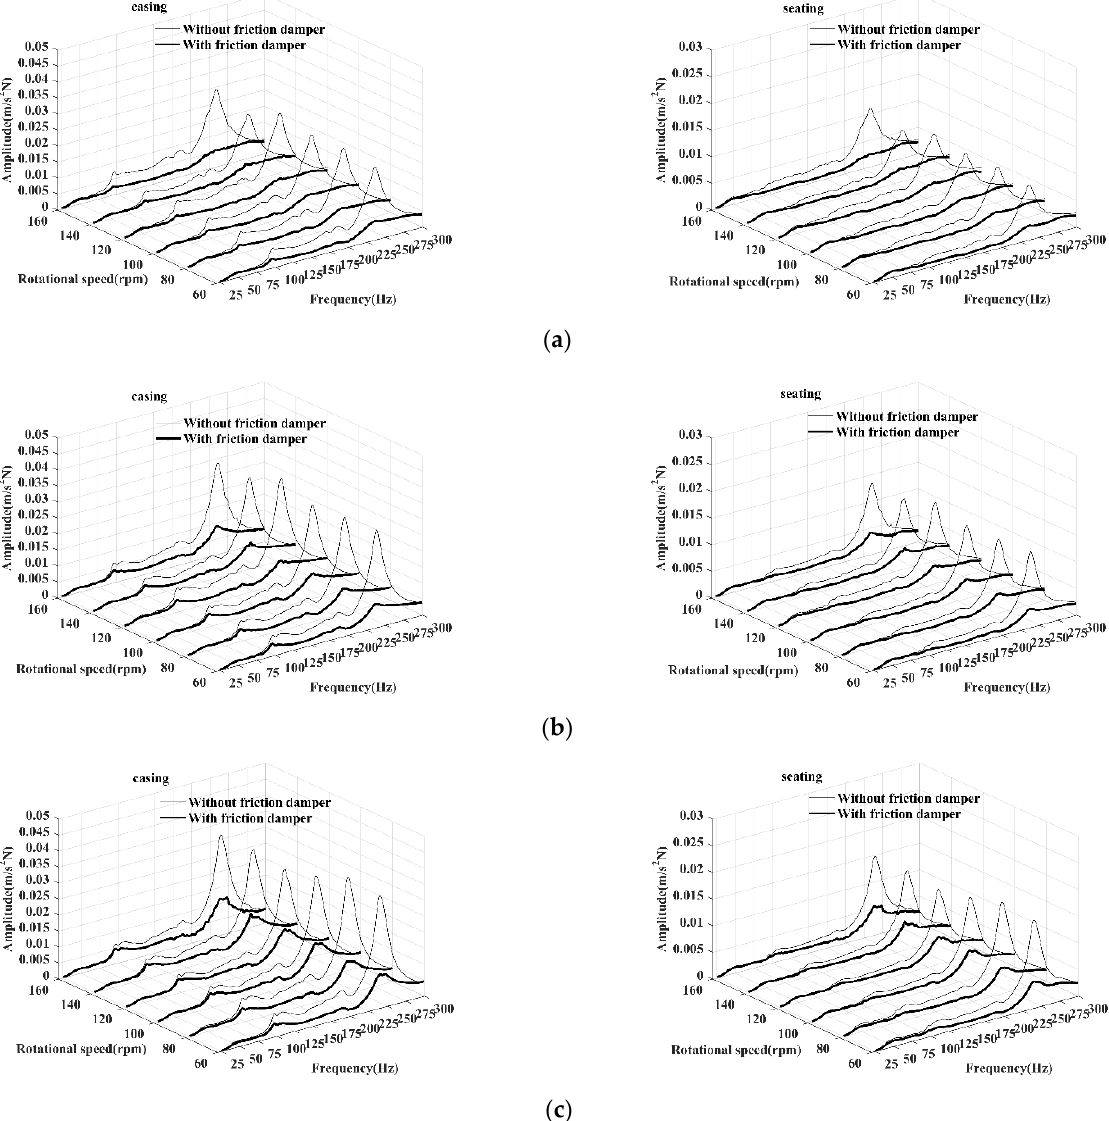
Figure 19. Comparisons of AFRF of thrust bearing under different static thrusts: ( a ) static thrust is10 kN; ( b ) static thrust is 30 kN; ( c ) static thrust is 50 kN. 10 kN; ( b ) static thrust is 30 kN; ( c ) static thrust is 50